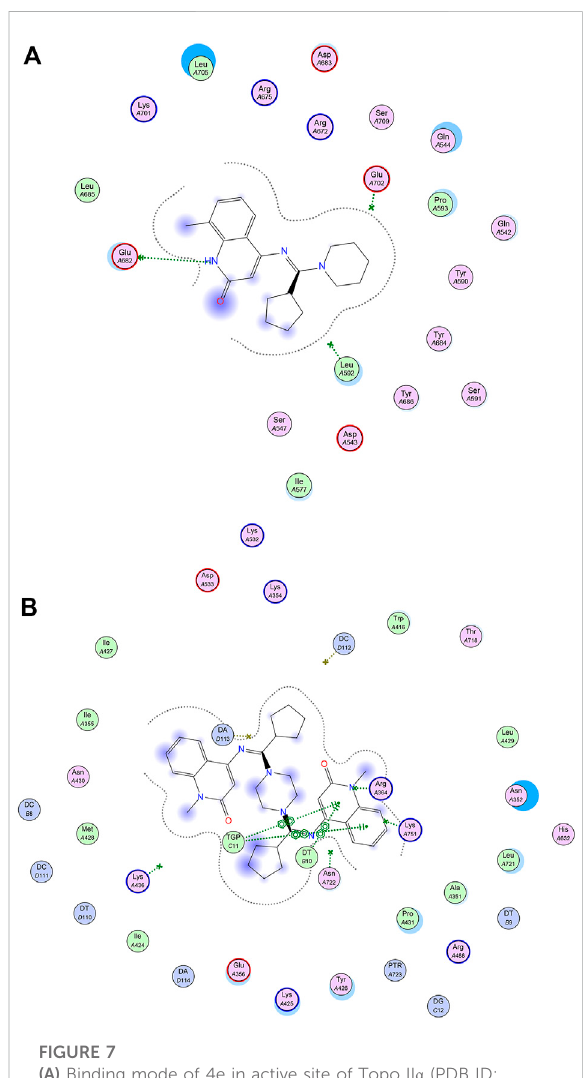
FIGURE 7 (A) Binding mode of 4e in active site of Topo II α (PDB ID: 4FM9); (B) Binding mode of 5c in DNA-Topo I complex (PDB ID: